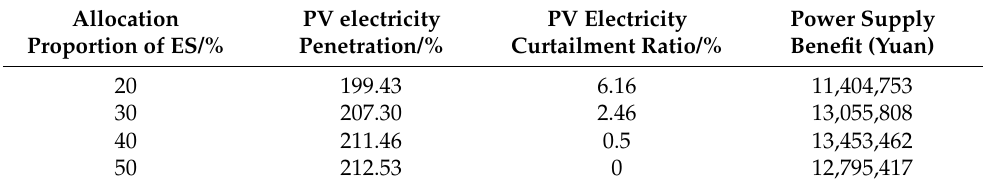
Table 5. Power supply benefit under different ratios of ES